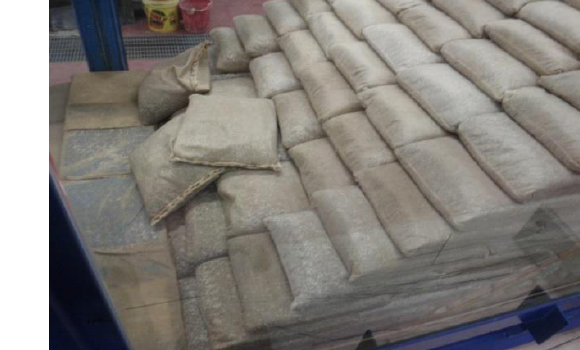
Figure 18. Configuration with slope 1:1. Instability of the structure in the stability test with H = 0.20 m, T = 2.0 s and h = 0.61 m.